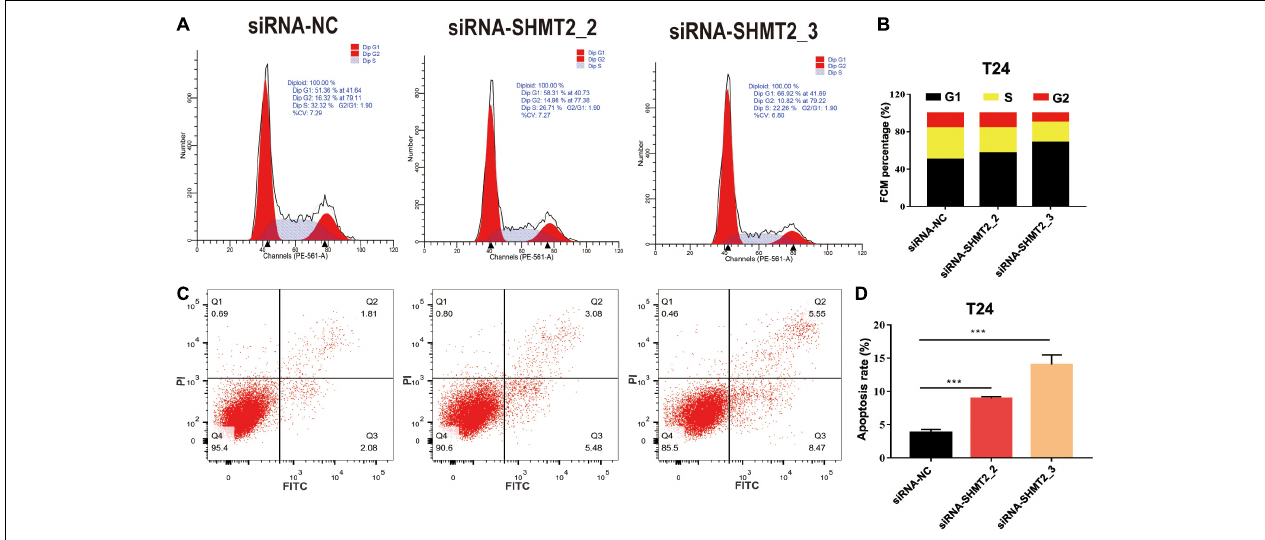
FIGURE 9 | Knockdown of SHMT2 impaired cell cycle progression and induced apoptosis. Knockdown of SHMT2 impaired cell cycle progression, (A) distribution of cells in three cell cycle phases was examined by flow cytometry assay, and the graph shows quantification for each phase (B) ( n = 3; *** P < 0.001). Knockdown of SHMT2 increased the rate of apoptosis, for measurement of apoptotic cells, cells were stained with both AV and PI, and analyzed by an image flow assay (C) , (D) graph illustrating the percentage of apoptotic cells ( n = 3; *** P < 0.001). AV, annexin V; PI, propidium iodide, P -value < 0.05 was recognized as statistically